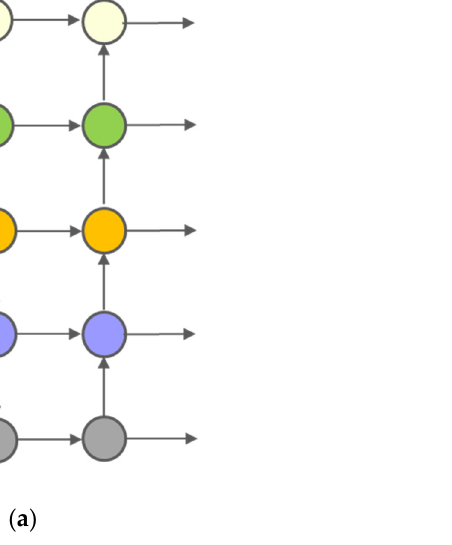
Figure 9. Structure of PANet (bottom-up secondary fusion) ( a ) and BiFPN (edges with contextual information added to the original FPN module) ( b ). information added to the original FPN module) ( b ).